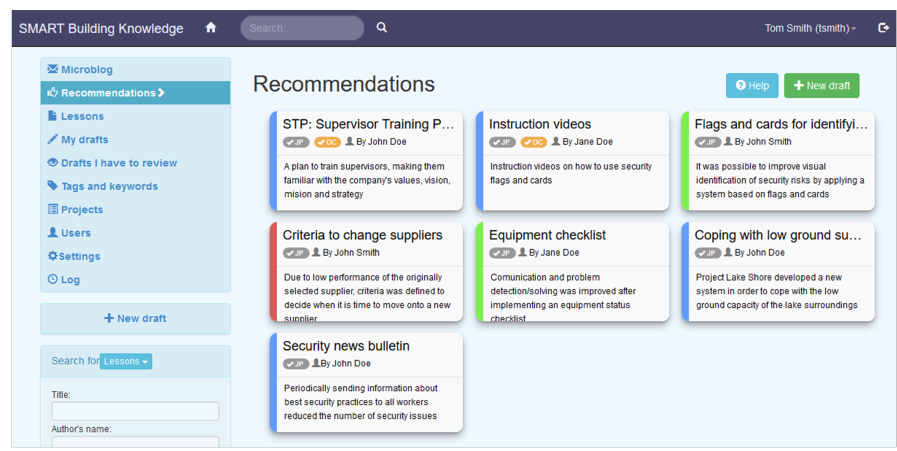
Figure 7. Front-end web application for the content-based recommendation